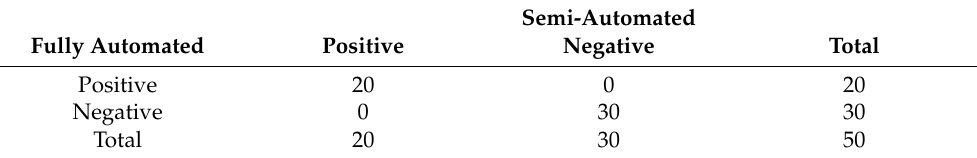
Table 1. Detected and undetected results on the semi-automated and fully automated assay.